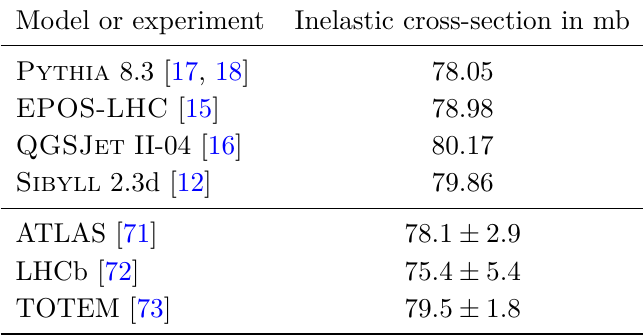
Table 2 . Inelastic cross-sections used in the models of which the predictions are compared with this measurement and values from recent measurements at the